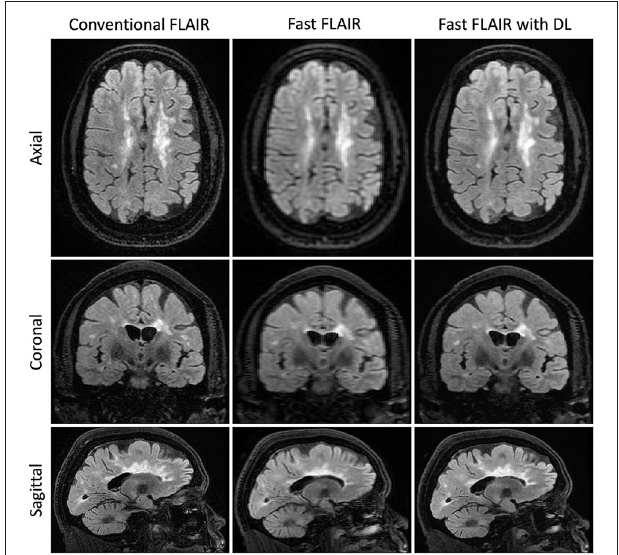
FIGURE 4 | Representative T2FLAIR images. Slices in a similar position for the acquisitions using three different methods: Conventional T2 FLAIR (6:40min total acquisition time, 256 × 224 × 240 matrix size), fast T2 FLAIR (1:13min total acquisition time, 256 × 128 × 120 matrix size), and fast T2 FLAIR with DL (same acquisition time and matrix size as the fast T2 FLAIR). FLAIR is the T2-weighted Fluid-Attenuated Inversion Recovery